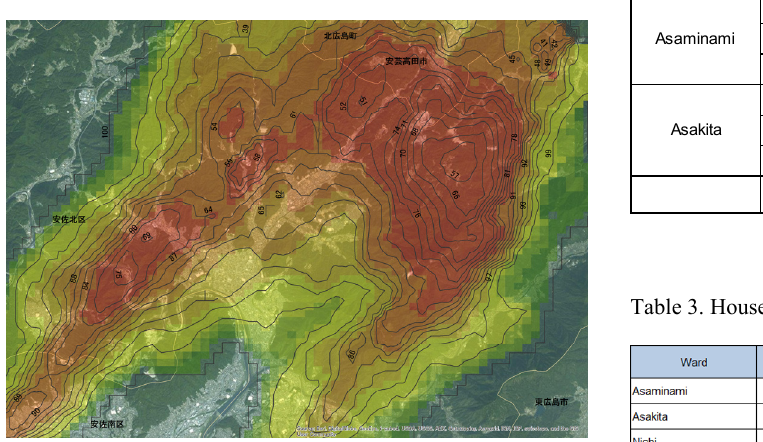
Figure 12. Analysis of rainfall data collected by the X-band MP radar (2014.08.20 4:00).